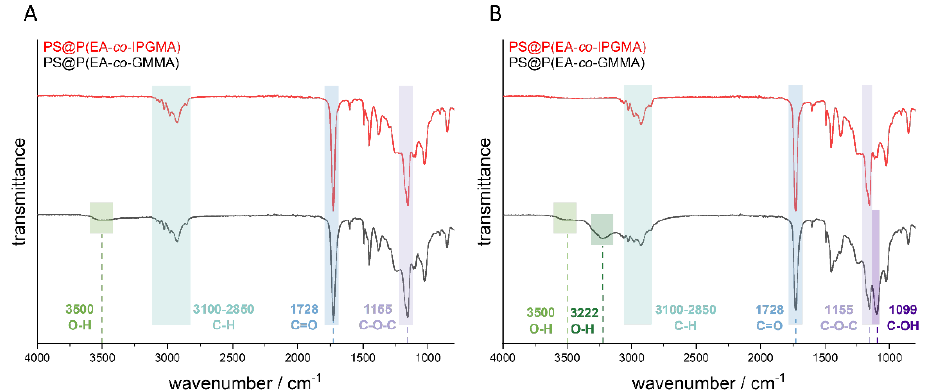
Figure 5. ATR-IR measurements of the synthesized opal films ( A ) with photoacid and ( B ) without photoacid.